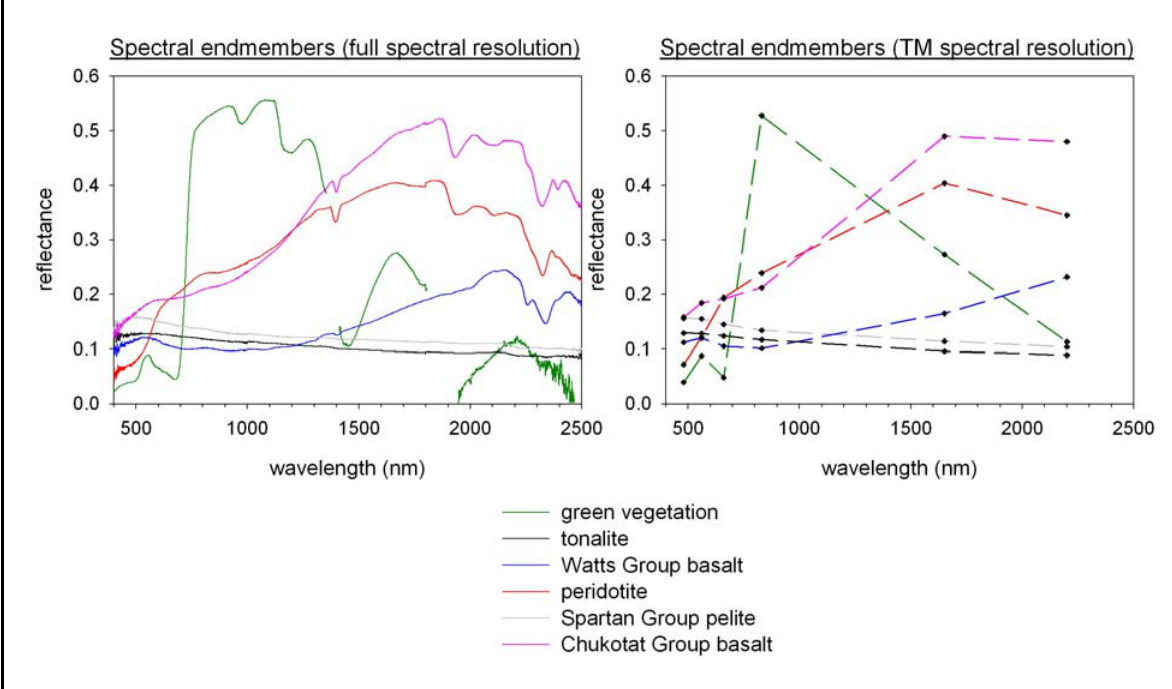
Figure 10. Six spectral end members were available for use in the unmixing of TM data for land pixels. Full-resolution end members are given at left and TM spectral equivalents are given at